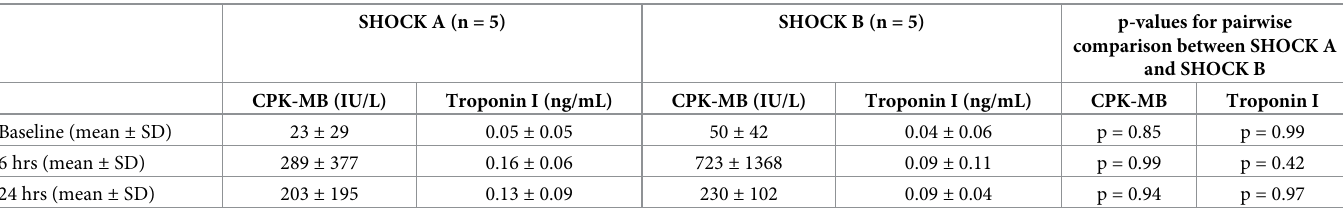
Table 3. Animal Study #3 biomarker levels at baseline, 6 hours, and 24 hrs post shock with Tukey-Kramer pairwise comparisons at each time point. SHOCK A (n = 5) SHOCK B (n = 5) p-values for pairwise